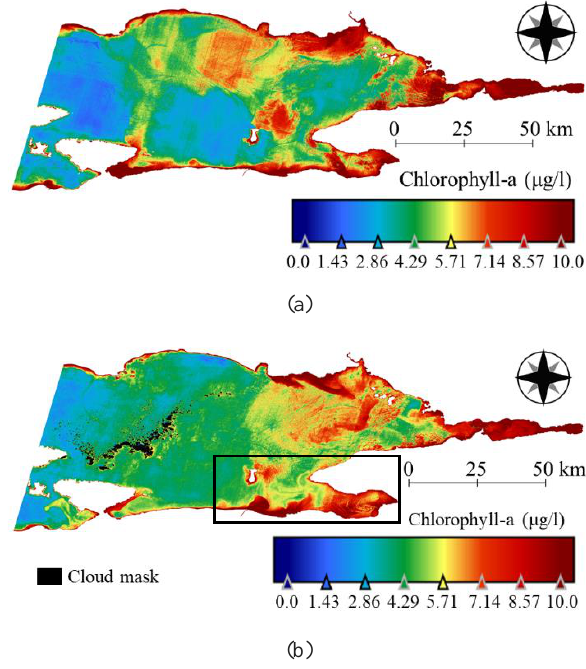
Figure 5. The distribution of chlorophyll-a concentration in a)